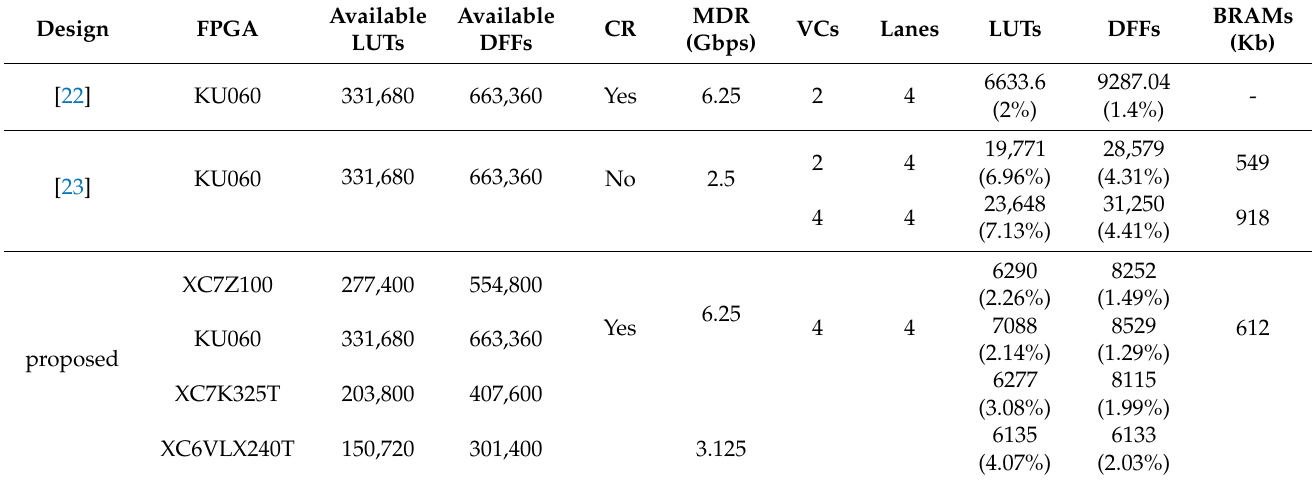
Table 1. Evaluation of hardware